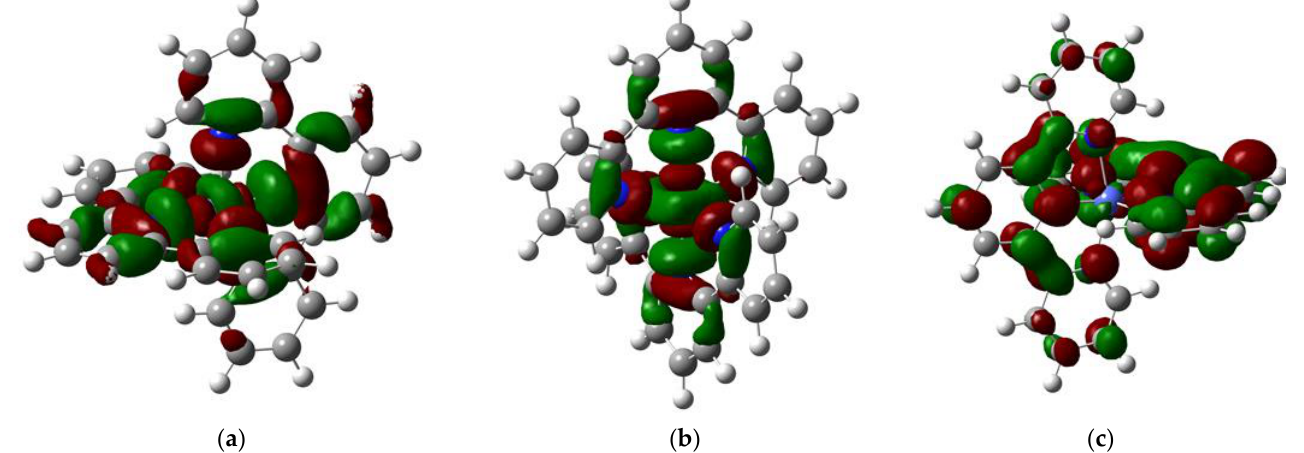
Figure 15. SOMO diagrams of the species ( a ) [Co II (terpy) 3 ] 2+ , ( b ) [Co I (terpy) 2 ] + , and ( c ) [Co I (terpy)(terpy − )].